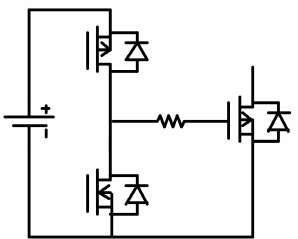
Figure 8. Conventional totem-pole gate driver.